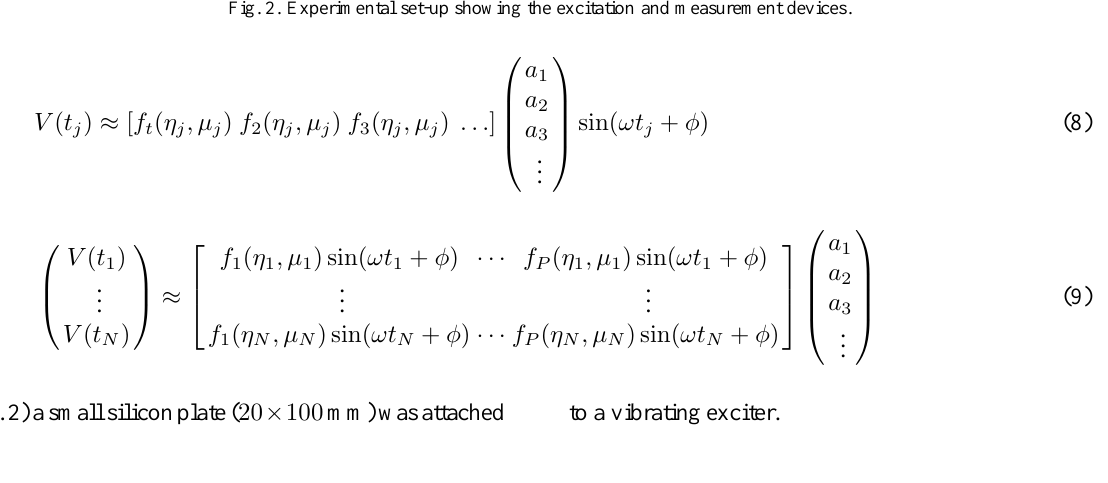
Fig. 2. Experimental set-up showing the excitation and measurement